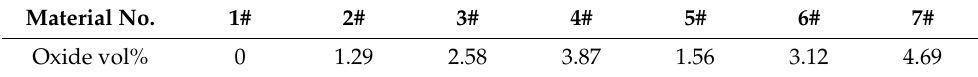
Table 2. Volume fraction of oxides in reactive